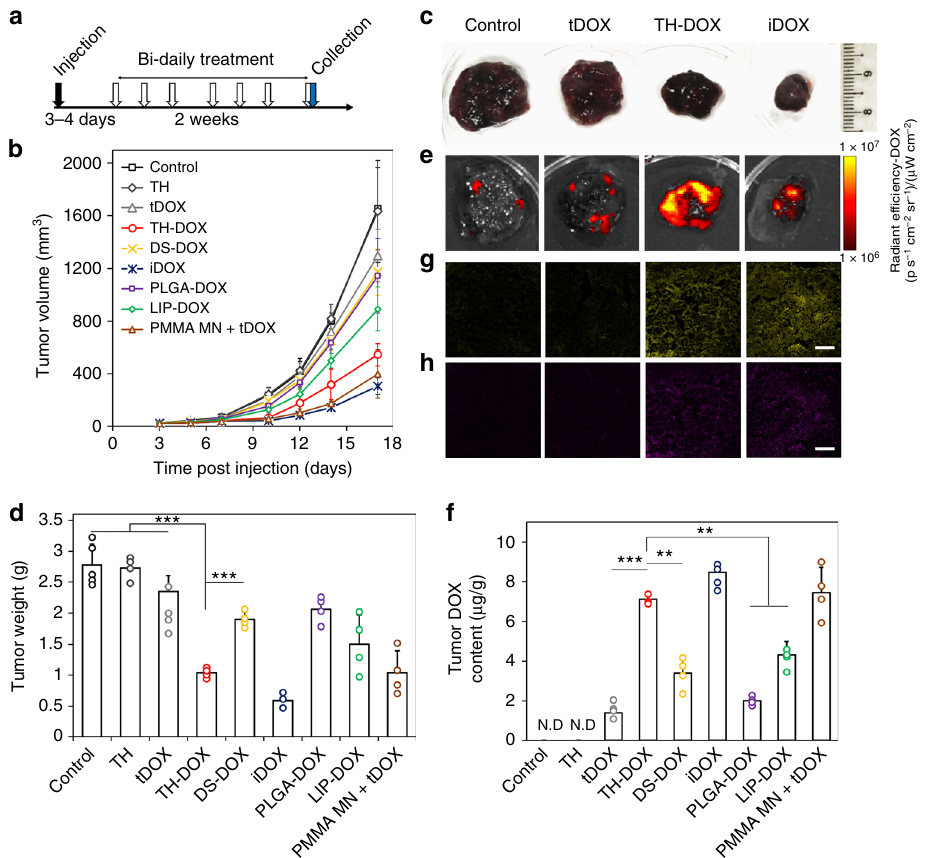
Fig. 6 Inhibition of tumor growth with various DOX formulations in melanoma mouse model: a Schematic showing experimental procedure. Bi-daily treatment started 3/4 days post injection and performed for 2 weeks till sacri fi ce. b Tumor size progression in mice treated with different DOX formulations. c Representative photo, d weight and e IVIS imaging for DOX channel of isolated tumor samples post control, tDOX, TH-DOX, and iDOX treatments at day 17. f Quanti fi cation of tumoral DOX content following tumor homogenization with generated fl uorescence standard curve. Each dot on bar charts represent independent sample measurement. Histological analysis of tumors in c for g Dox fl uorescence (yellow channel) and h Annexin V expression (purple channel), scale bar: 100 µ m. Source data are provided as a Source Data fi le. Error bars represent standard deviation. N.D: non- determinable, ** p < 0.01, *** p < 0.001 as compared to TH-DOX (one-way